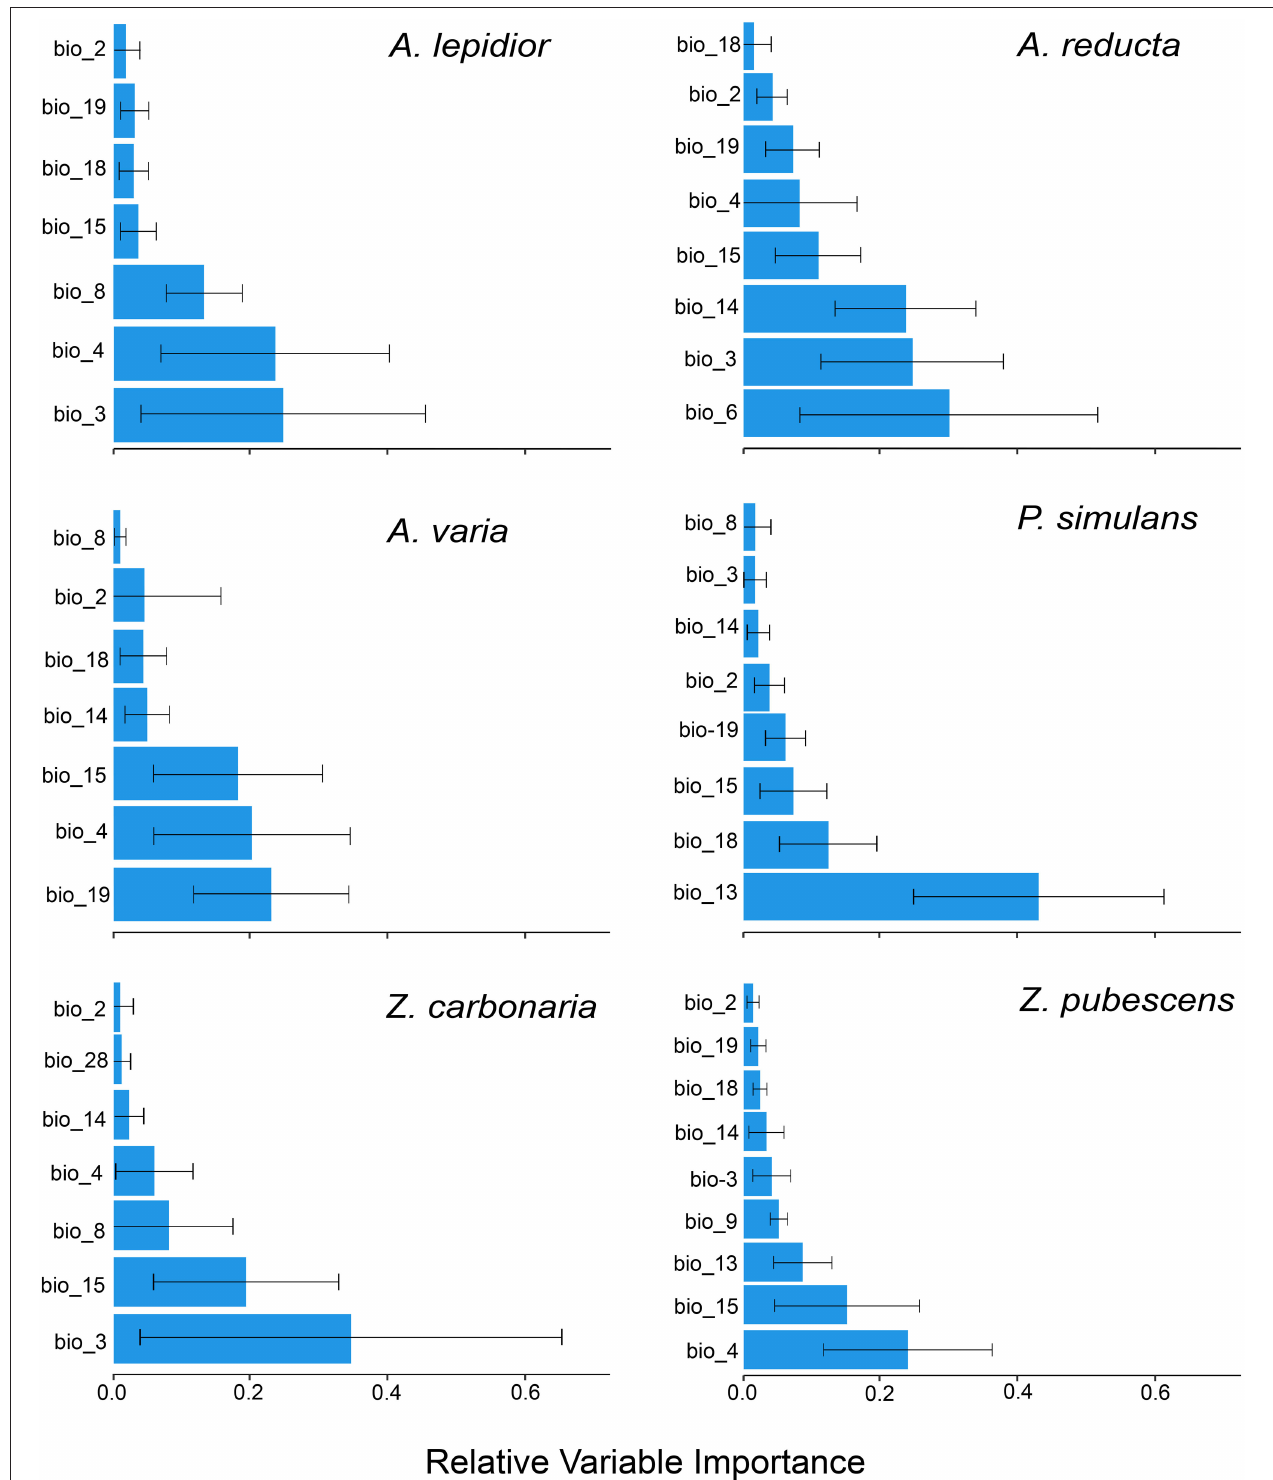
FIGURE 7 | Relative variable importance in modeling the ecological niche of each species of spittlebugs. Error bars represent the standard deviation of all 24 models. The graphs show only bioclimatic layers selected based on multicollinearity analysis for each species.